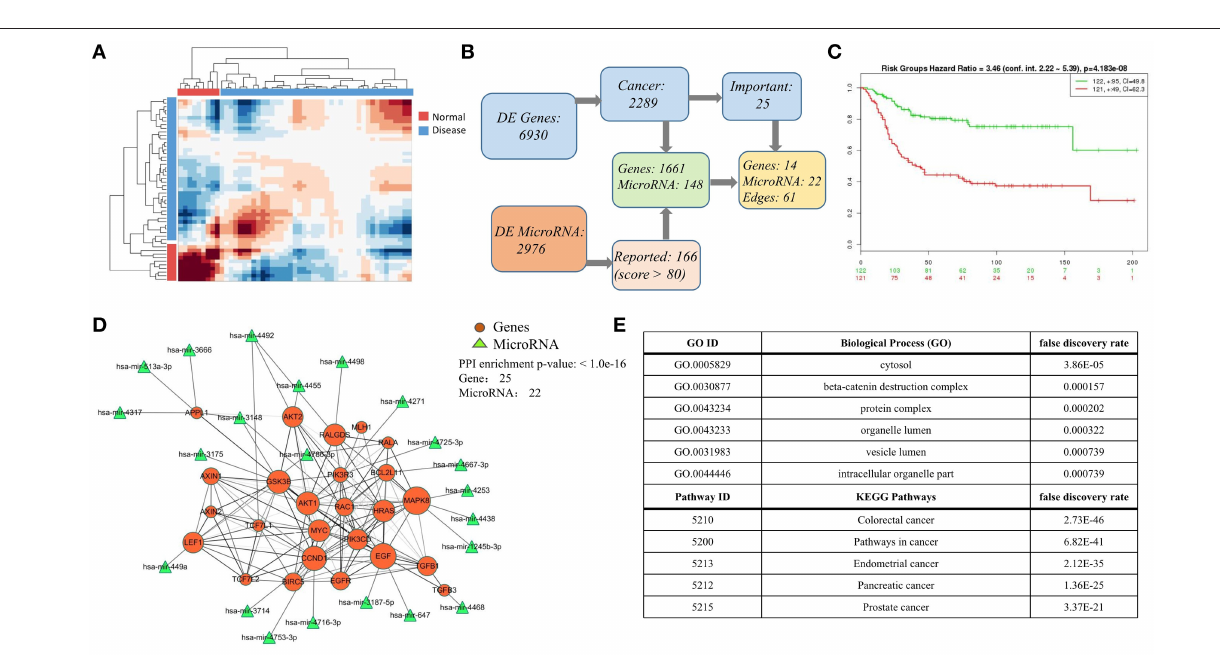
FIGURE 5 | Case study on the colorect cancer (A) Hierarchical clustering diagram of samples in matrix Y . Color bars represent the normal samples and disease samples. (B) The process diagram of selecting key genes. (C) Evaluation of the selected 25 important genes related to colorectal cancer in (B) . In SurvExpress, we used the average for selected genes, two risk groups and Cox fitting to generate Survival curves. The total number of each group is shown in the top right corner of graph, and the number of censoring samples is marked with + . The CI per curve is also included. P -value is shown in the top of figure. (D) The highly connected network consists mainly of 25 DEG genes and 22 miRNAs. The 22 miRNAs targets 16 genes based on miRDB database. The size of node indicates the network degree of gene. And the PPI enrichment P -value of genes is shown in the top right corner of this figure. (E) Top-ranked pathways and biological functions enriched in the 25 genes in (D)